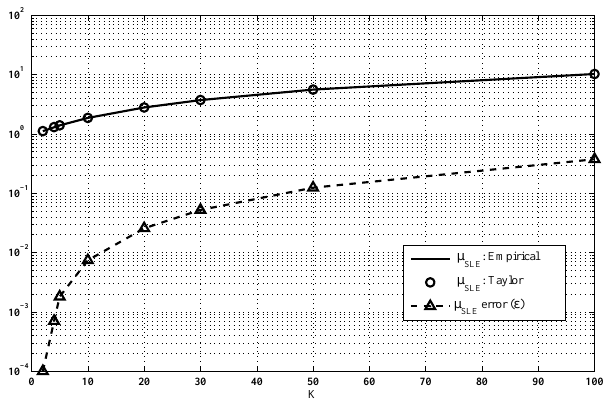
hypothesis and 1